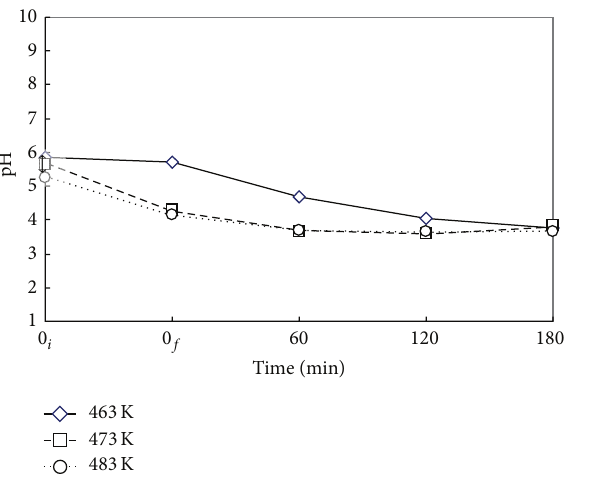
Figure 6: Timevariation of pH value forthedecomposition of DMP via WOP at various 𝑇 . ⬦ , ◻ , and I : 𝑇 = 463, 473, and 483 K. 𝐶 0 = 100mg L −1 , 𝑉 𝐿 =400 mL, 𝑃 𝑇 =2.41 MPa,andNr=500 rpm.Working gas after time = 0 𝑓 is O 2 . ↕ : Mean and Standard deviation (SD, 𝑛 − 1 method) at 𝑡 = 0 𝑖 : 5.6 ± 0.3.